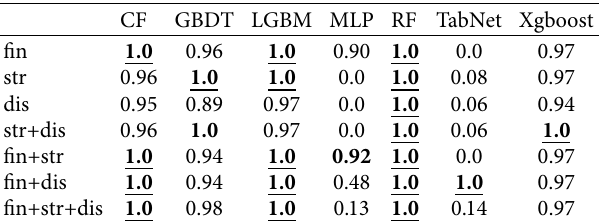
Table 3: Te performances of features and models in the default event classifcation